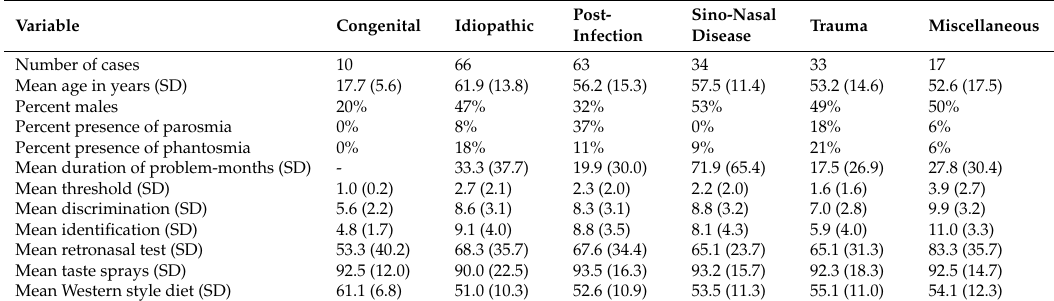
Table 3. Descriptive statistics of the case series by cause of olfactory loss.